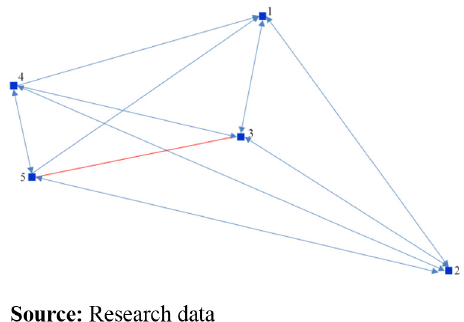
Figure 4. Graph of incubator